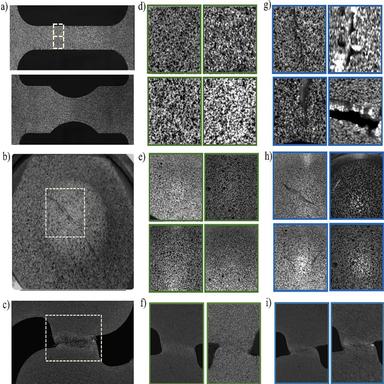
Uniaxial tension, notched tension (a), punch (b), and shear (c) speckle-pattern original-size image data. Uncracked (d, e, f) and cracked (g, h, i) small-size images are provided for each experimental testing case in the middle and rightmost column respectively, highlighting the distinct grayscale and texture in each case.